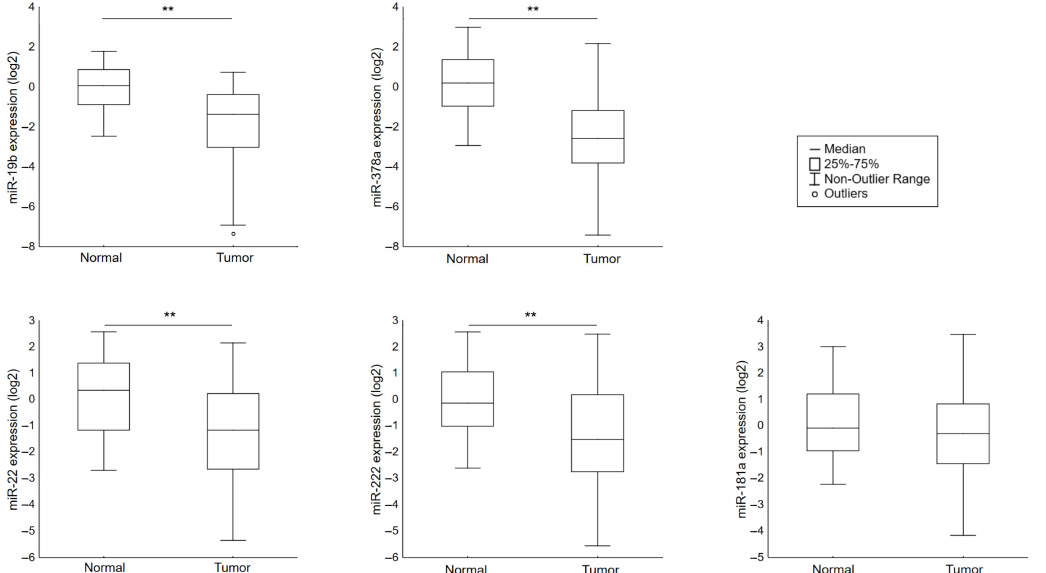
Figure 1. The comparison of microRNA expression between normal and cancerous tissue groups. The Y axis presents the expression level (log 2 – ∆ Ct ). ** p < 0.0001. 2